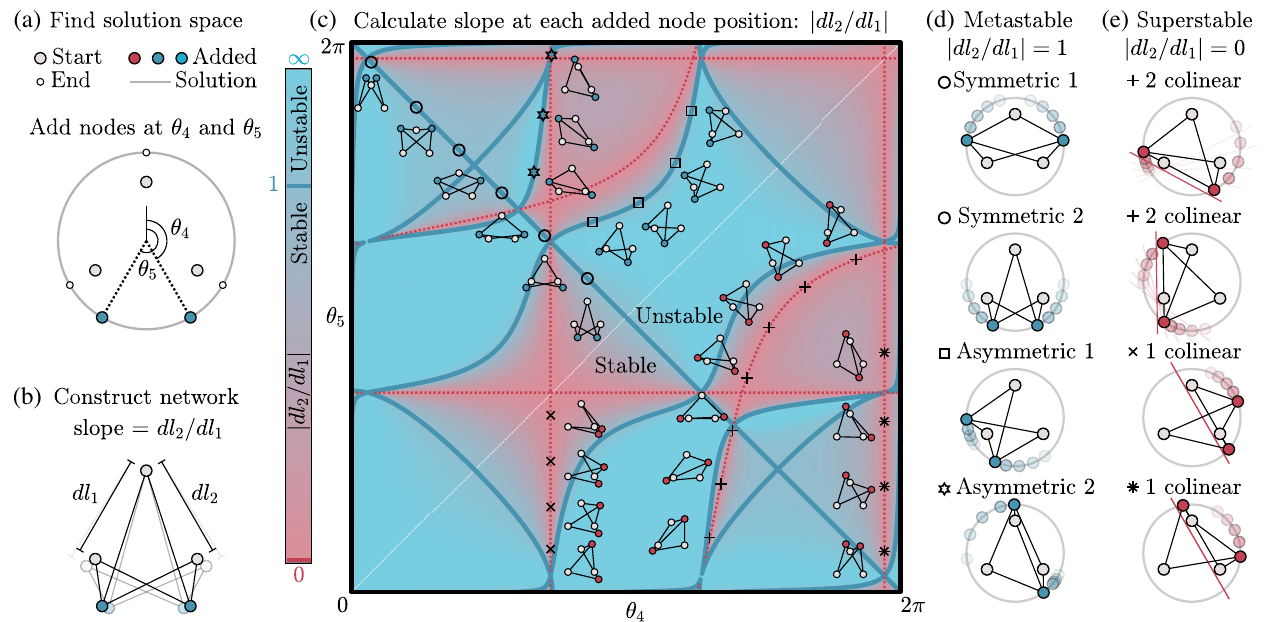
FIG. 10. Designing the sequence of conformational change. (a) Schematic of the addition of two nodes along the solution space, parametrized by angles θ 4 and θ 5 . (b) At the start position, connecting the added nodes to the initial nodes with edges yields one conformational motion, characterized by a slope of d l 2 = d l 1 . (c) Phase diagram of the slope magnitude at all placements of added nodes. The solid blue line marks the transition between stable and unstable. The red dashed line marks where the slope equals zero. (d) Units with j slope j ¼ 1 and (e) with j slope j ¼ 0